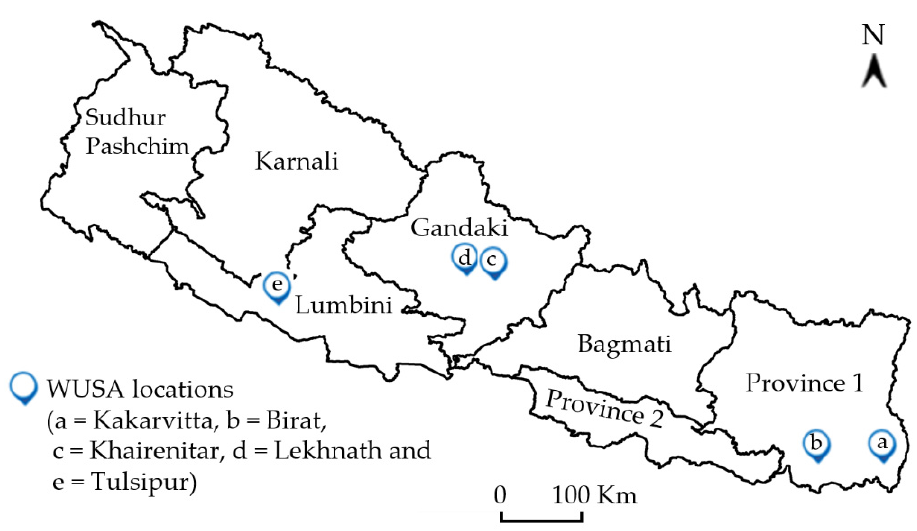
Figure 2. WUSA location in Nepal.